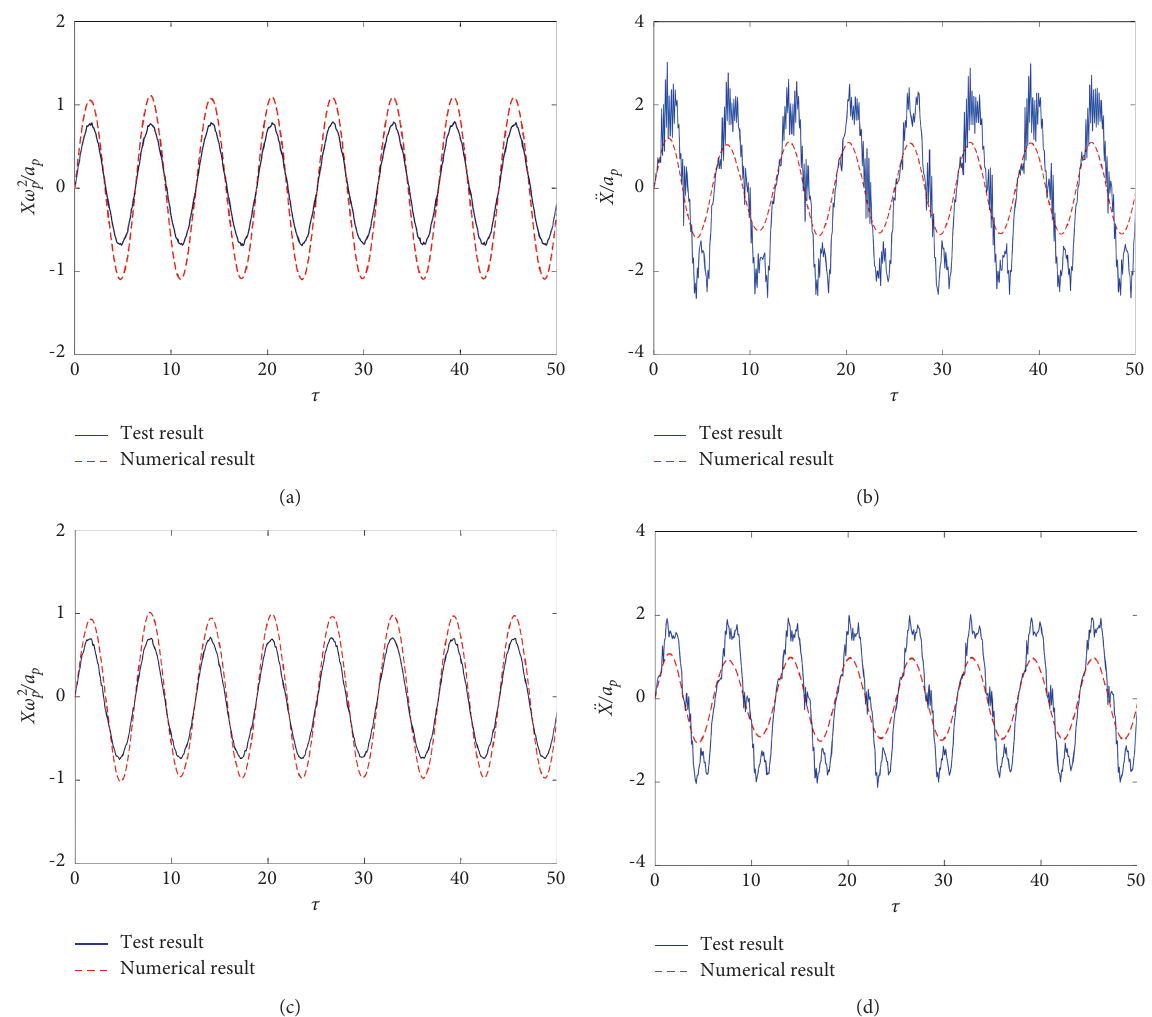
Figure 13: Displacement and acceleration histories of the top and third floors of the four-story steel frame structures without pounding. (a) Dimensionless displacement histories of the top floor. (b) Dimensionless acceleration histories of the top floor. (c) Dimensionless displacement histories of the third floor. (d) Dimensionless acceleration histories of the third